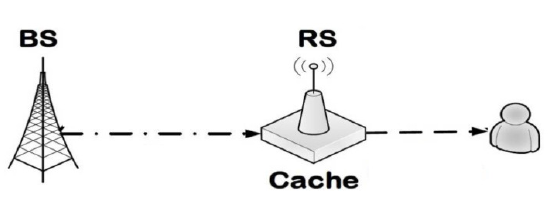
Figure 1. Relay system